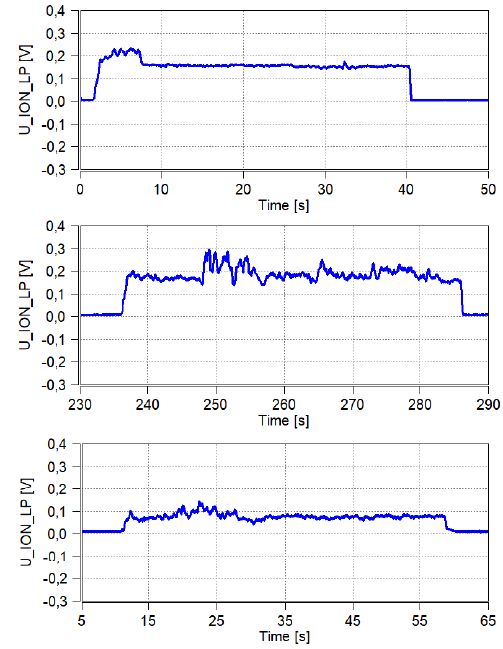
Fig. 4. Ionization voltage signal waveform; measuring points, from the top: 1, 3 and 8 cm above the burner (spark plug No. 2)